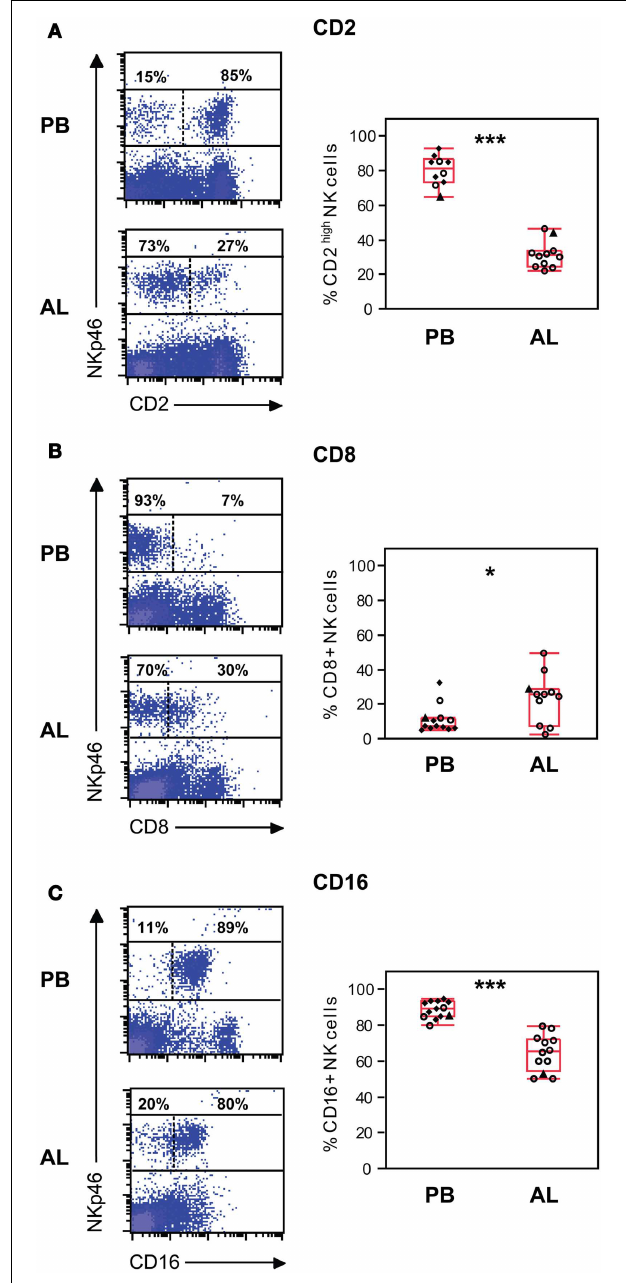
FIGURE 2 | Phenotype of NK cells ex vivo . NK cell expression of the surface molecules CD2 (A) , CD8 α (B) , and CD16 (C) . Gating of cells as in Figure 1 . Density plots (left panels) of representative animals from peripheral blood (PB) and afferent lymph (AL). Numbers indicate the percentage of NKp46 + cells above or below an expression threshold (dashed line) for the indicated molecule. Distribution of the results (right panels) showing % positive NK cells in PB ( n = 10–13) and AL ( n = 11–12). Symbols and statistics as in Figure 1 (* p < 0.05, *** p <